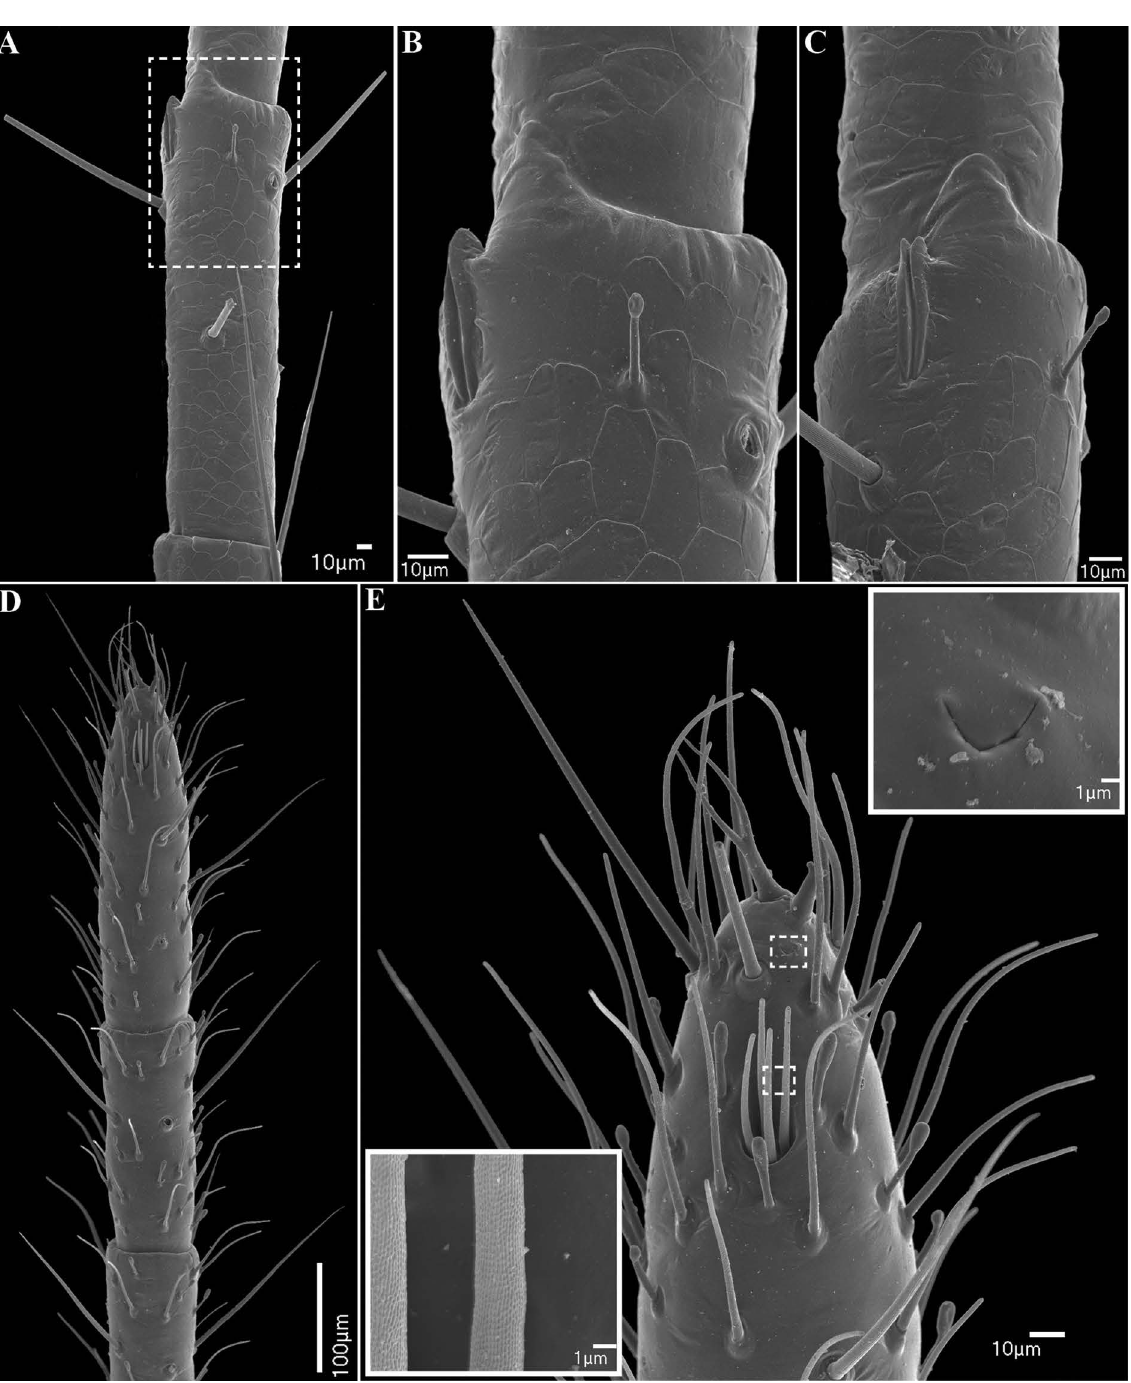
Fig. 129. Sarax tiomanensis sp. nov. (AMCC [LP 11998]), antenniform leg I, ♀. A . Tarsal article 19 with projected slit sensilla. B . Slit sensilla on tarsal article 19. C . Slit sensilla on tarsal article 19, frontal view. D . Apex of distal article of tarsus. E . Distal article of tarsus showing rod sensilla, modified claw and tarsal organ. Upper inset: slit sensilla near base of tarsal organ. Lower inset: